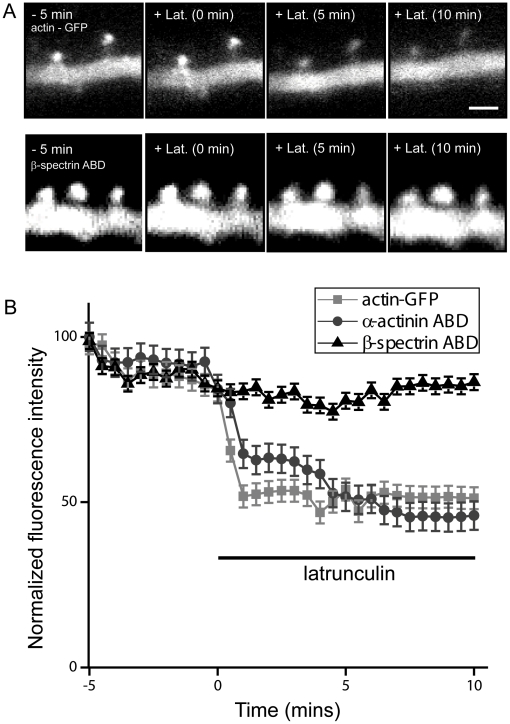
The ABD of βI-spectrin prevents acute actin depolymerization.
A, Images of GFP fluorescence in spines from CA1 pyramidal neurons expressing actin-GFP alone (upper row), or co-expressing actin-GFP together with the ABD of βI-spectrin (lower row) before and after the application of 5 µm latrunculin-B. Note that fluorescence decreased within 5 minutes of latrunculin treatment in cells expressing GFP, but not in cells co-expressing the spectrin ABD. Scale bar = 2 µm. B, Normalized fluorescence emission of dendritic spines was imaged every 30 seconds before and after the addition of latrunculin-B. Fluorescence decreased rapidly (<3 min) in spines expressing actin-GFP alone and in spines in which the ABD of α-actinin was co-expressed, but not in spines co-expressing the ABD of βI-spectrin and actin-GFP (n = 5 neurons/construct; p<0.001, repeated measures ANOVA).